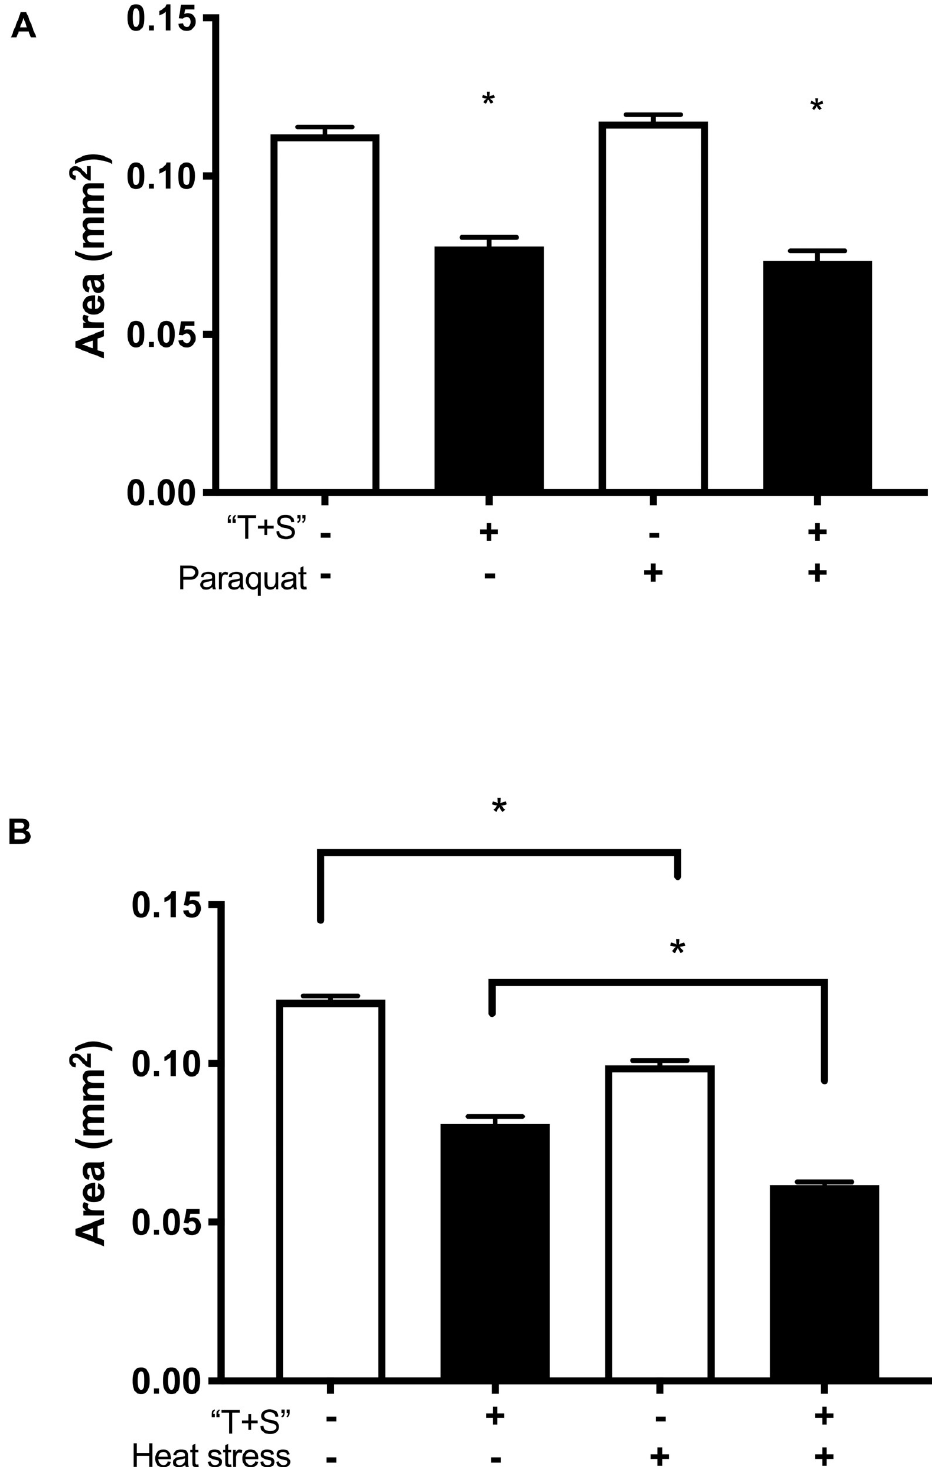
Fig 3. Growth is further stunted by combined exposure to heat stress and “T+S”. Cross-sectional area of day 5 C . elegans raised on “T+S” or control plates was measured 8 hours after exposure to either paraquat (a known oxidative stressor), 35˚C heat stress, or a water control. C . elegans were imaged and then measured using Image J/FIJI software. A total of 36–64 worms were analyzed for each treatment group or control. Data were analyzed using a 1-way